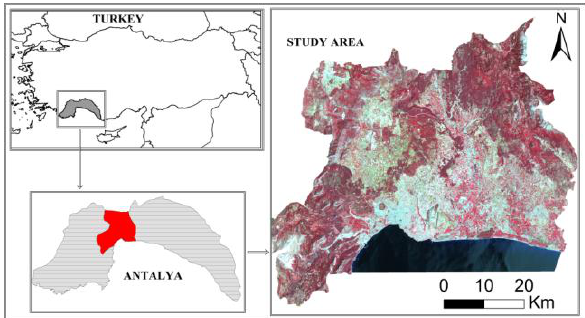
Figure 1. Landsat 8 image of the study area and its location in Antalya in Turkey